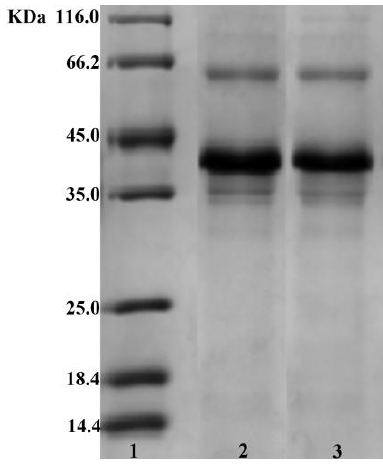
Figure 1. SDS-PAGE analysis of phosvitin (Pv) and the phosvitin-gallic acid (Pv–GA) complex; line 1: marker; Line 2: Pv–GA complex; Line 3: marker; Line 2: Pv–GA complex; Line 3: Pv.